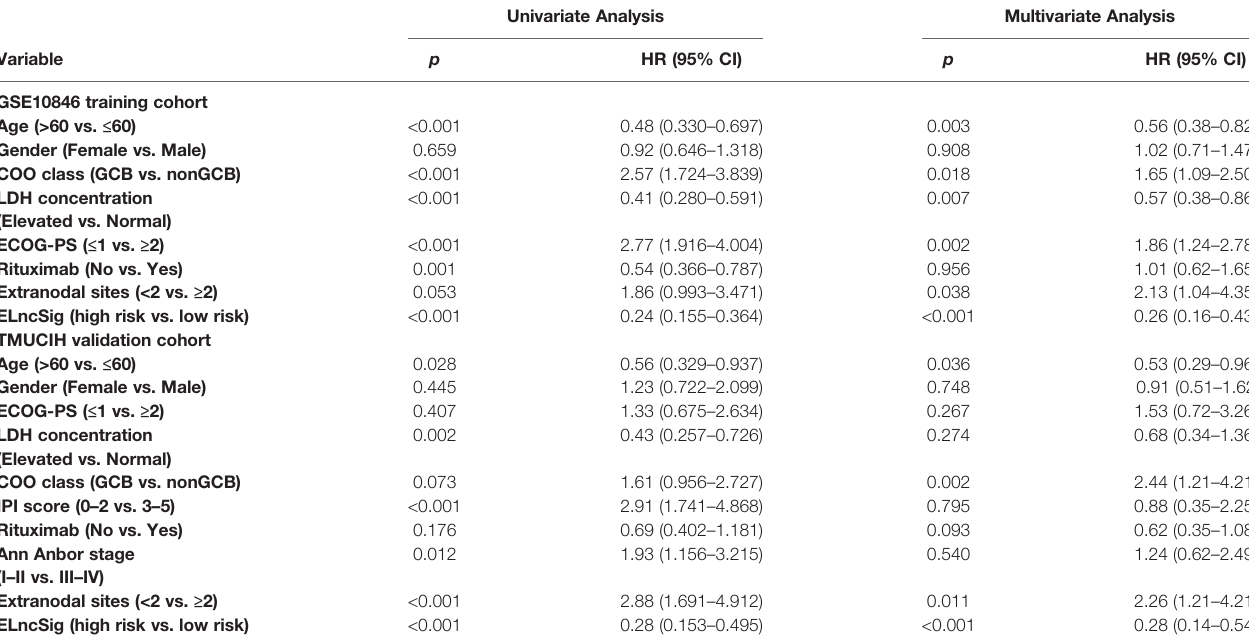
TABLE 2 | Univariate and multivariate Cox regression analysis of predictors of survival outcomes in the training and validation cohorts. Univariate